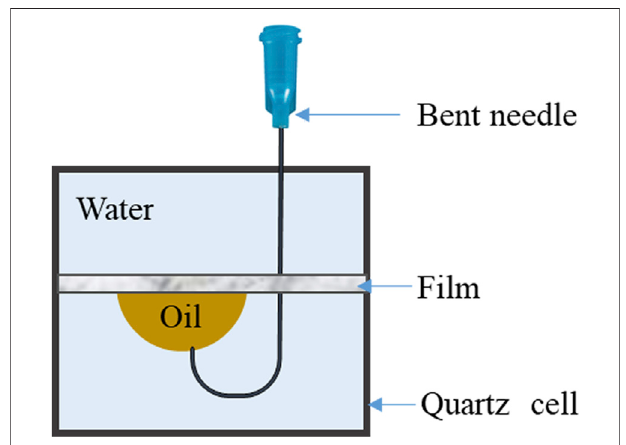
FIGURE 1 | Schematic diagram showing the contact angle test method for the MPL fi lm with white oil in an aqueous